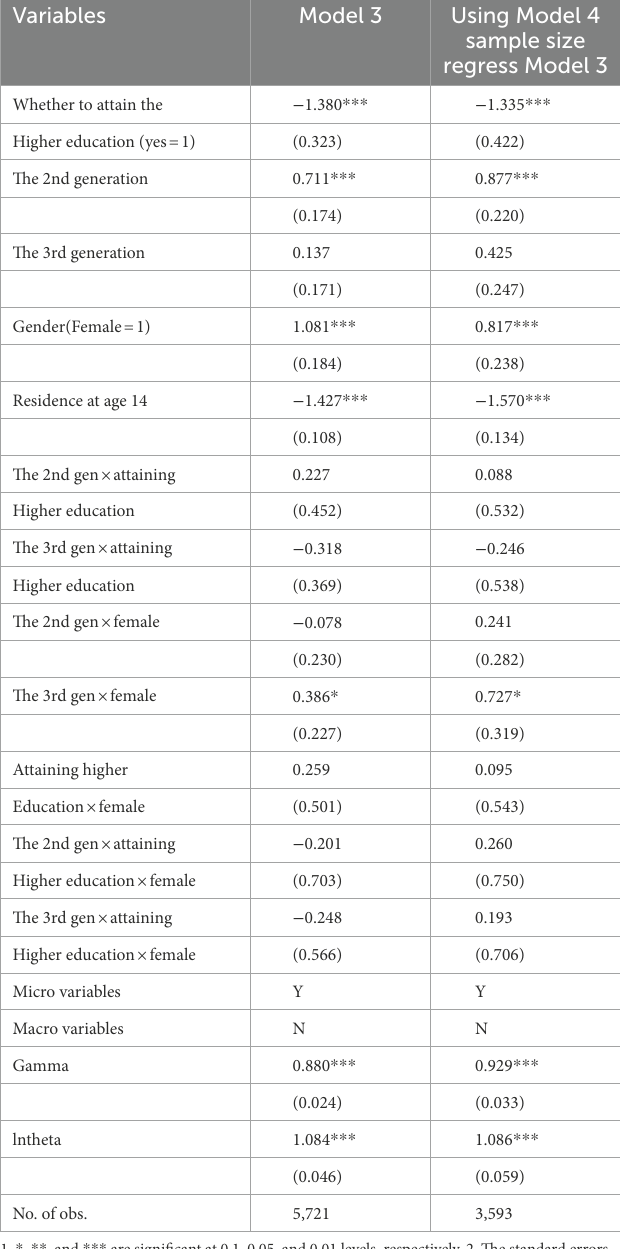
TABLE 3 The robustness